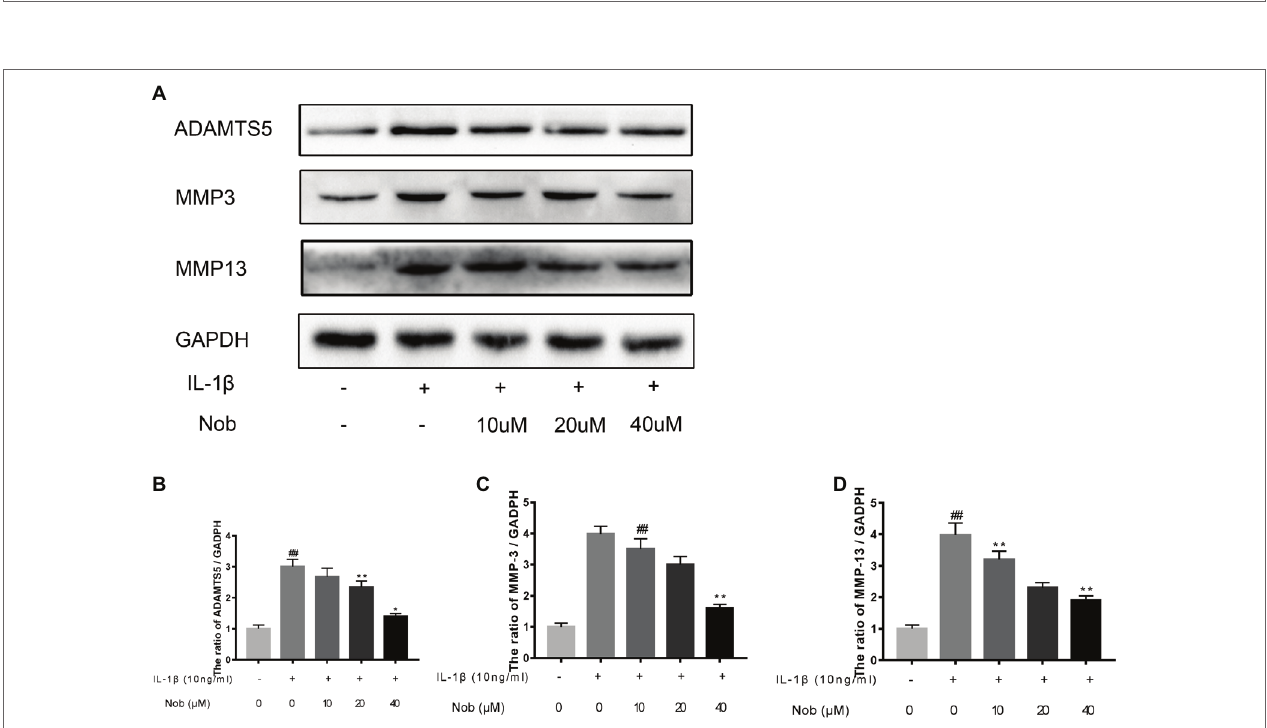
FIGURE 4 | Effects of nobiletin on MMP-3, MMP-13, and ADAMTS-5 expression in chondrocytes. Cells were pretreated with various concentrations of nobiletin (0, 10, 20, or 40 μM, 24 h) prior to stimulation with IL-1 β (10 ng/ml, 24 h). Expression of MMP-3, MMP-13, and ADAMTS-5 was evaluated by Western blot analysis (A–D) . Values represent mean ± SD of three independent experiments. Significant differences are indicated as * p < 0.05, compared with control group. * p < 0.05 and ** p < 0.01, compared with IL-1 β group. ## p < 0.01, compared to the control